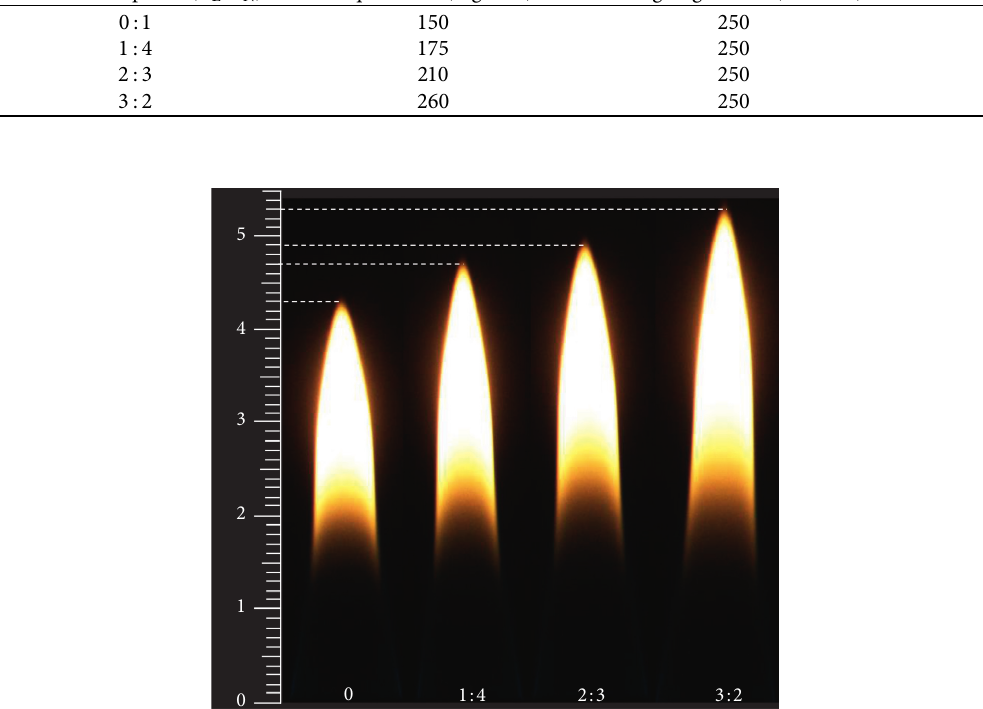
Figure 2: Still pictures of n- heptane mixed with different amounts of